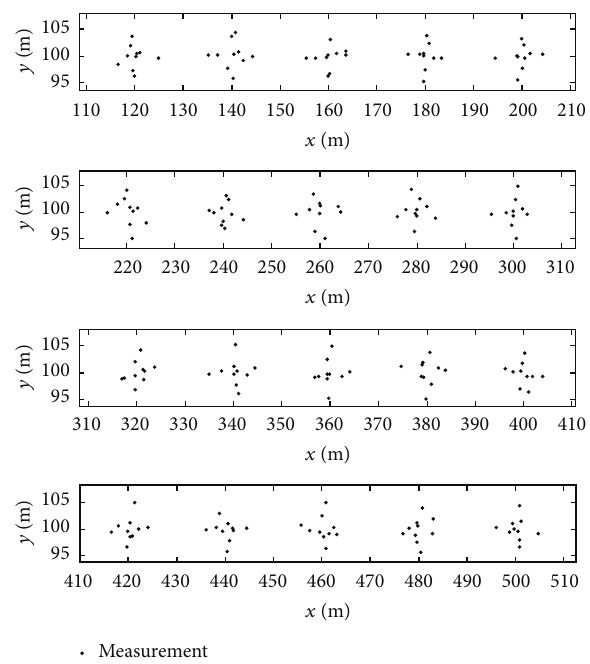
Figure 3: The real measurements of the extended target (1 ∼ 20